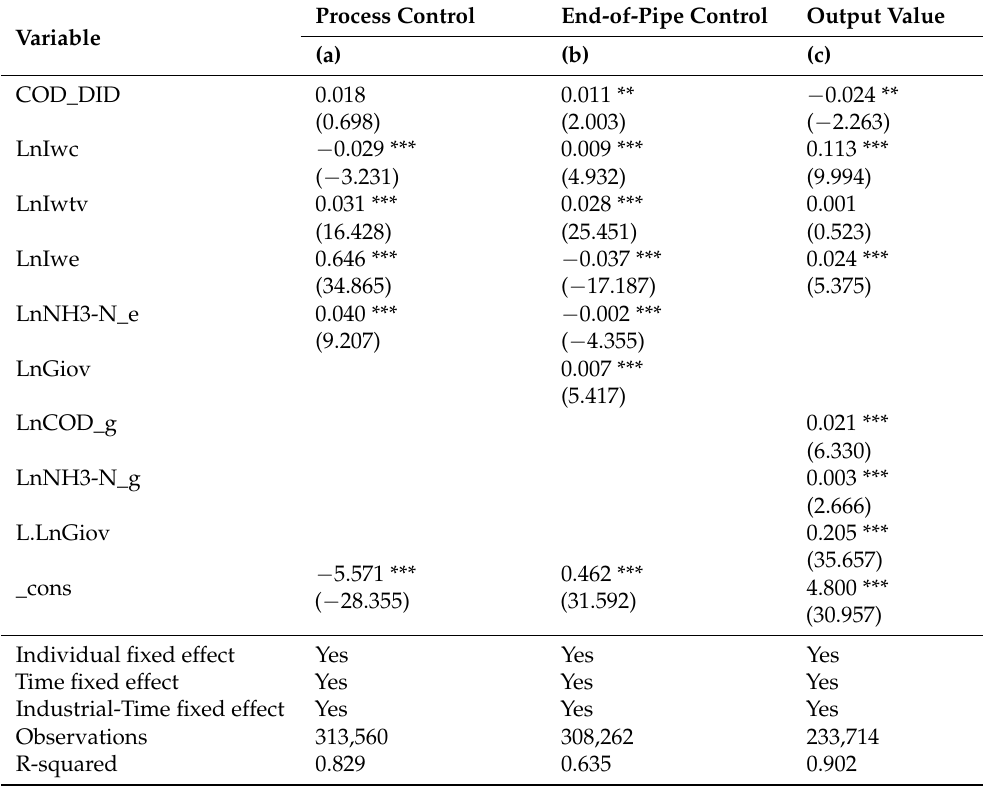
Table 8. Mechanism